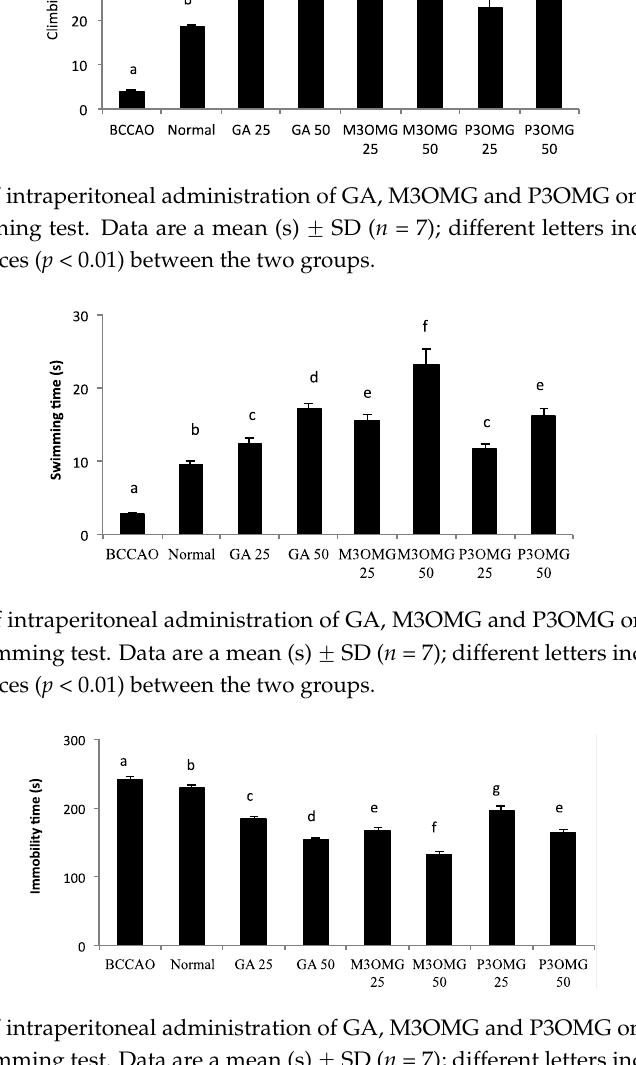
Figure 5. Effects of intraperitoneal administration of GA, M3OMG and P3OMG on immobility time in the despair swimming test. Data are a mean (s) ± SD ( n = 7); different letters indicate statistically significant differences ( p < 0.01) between the two groups.